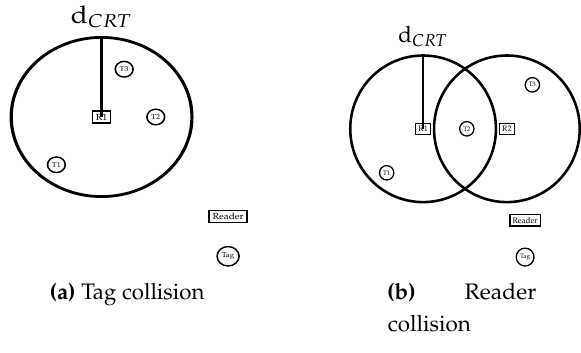
Figure 1. RFID collisions.